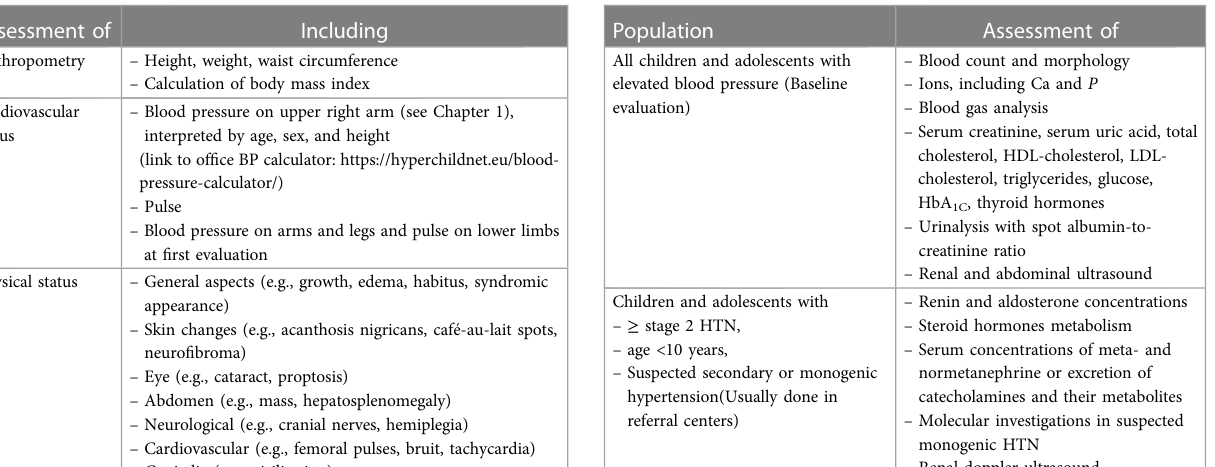
TABLE 3 Recommended evaluation in children and adolescents with